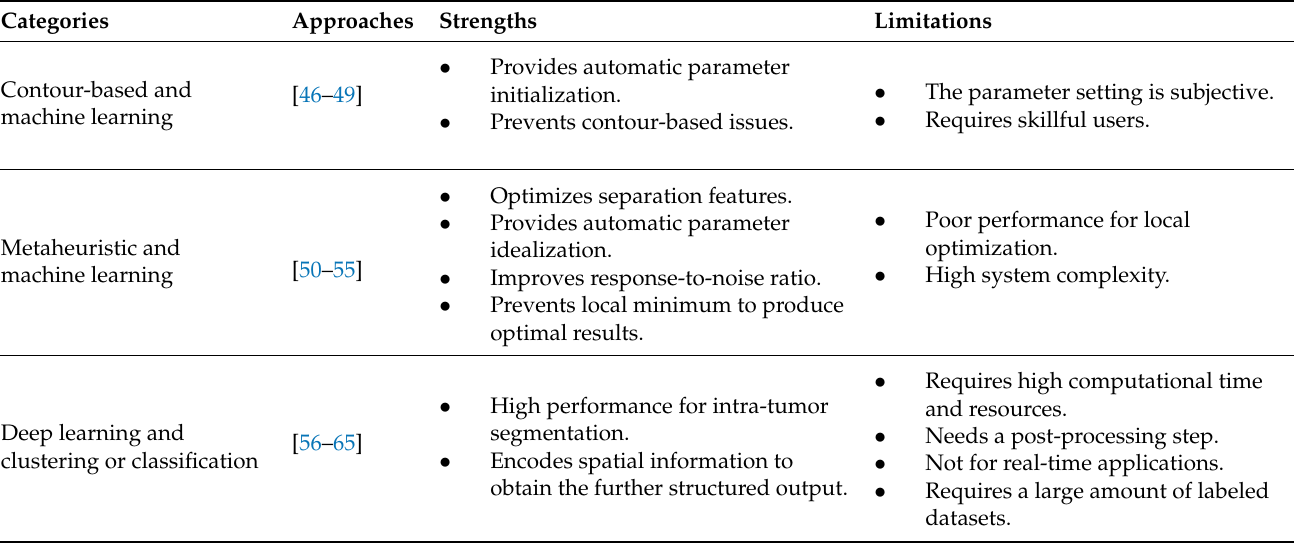
Table 2. Strengths and limitations of hybrid segmentation